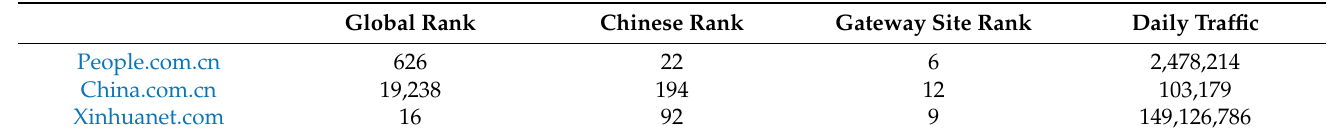
Table A1. Traffic Statistics of Three Selected Websites.